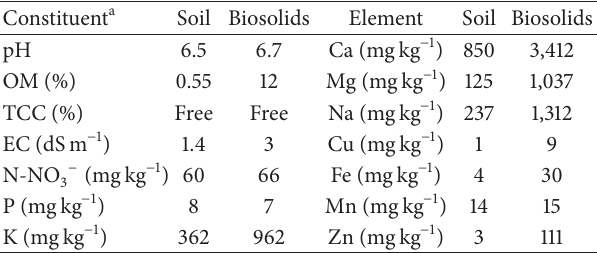
Table 1: Soil chemical properties before biosolids application and biosolids composition from the North Wastewater Treatment Plant at Chihuahua city,